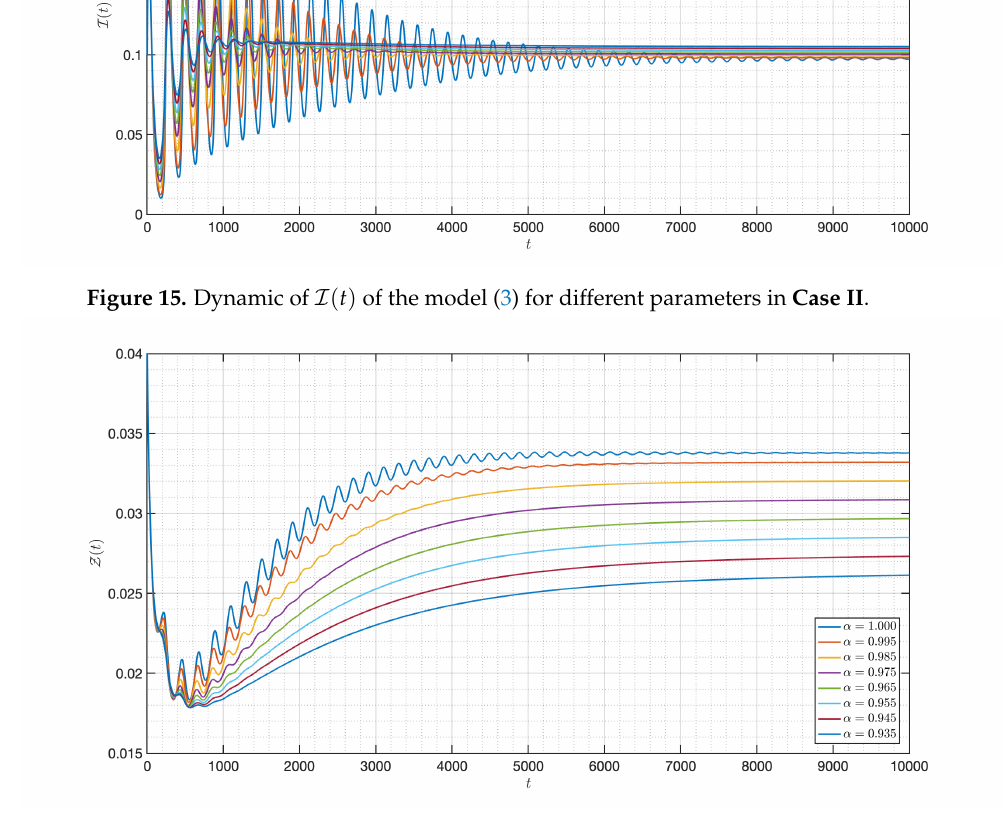
Figure 16. Dynamic of Z ( t ) of the model (3) for different parameters in Case II .